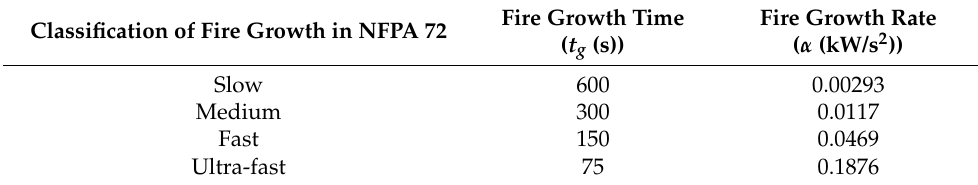
Table 1. Values for α and t g for different classifications of fire growth in NFPA 72.